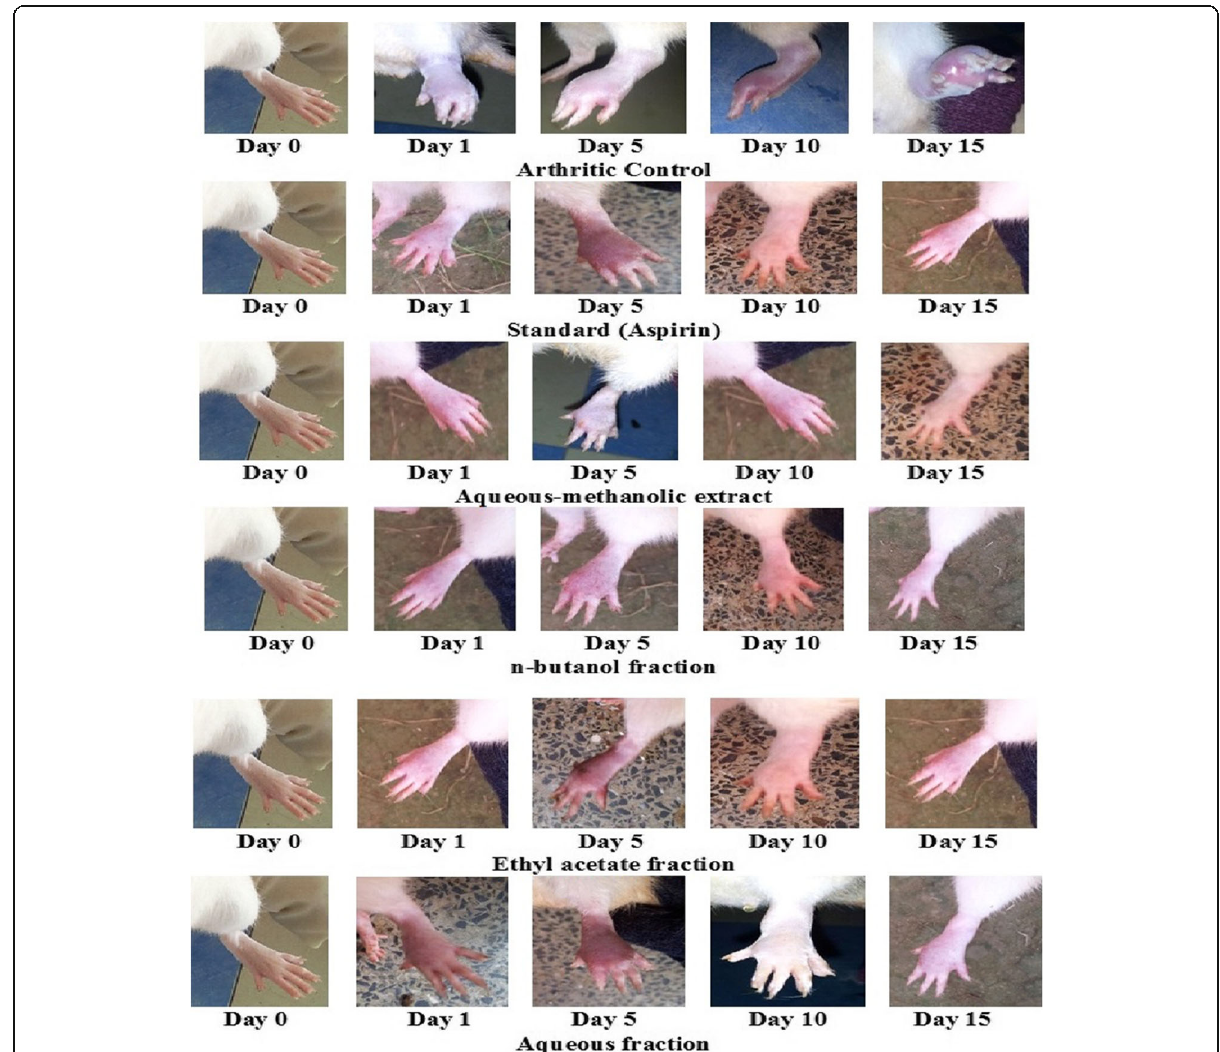
Fig. 4 Photographic analysis (changes in paw diameter) of CFA induced arthritis in Sprague Dawley